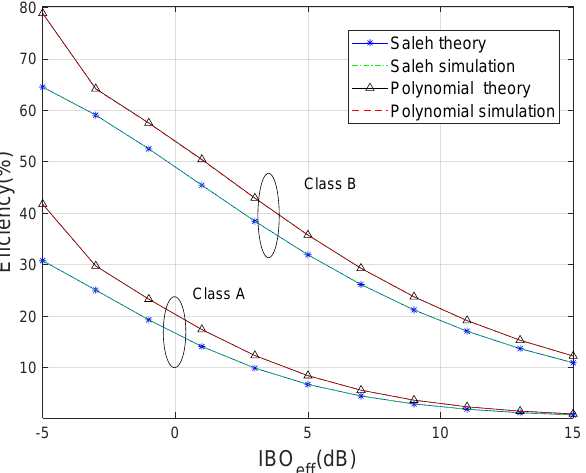
Figure 5. The efficiency of Class A and Class B PAs as a function of the effective IBO (Class A and Class B PAs, Saleh, and polynomial